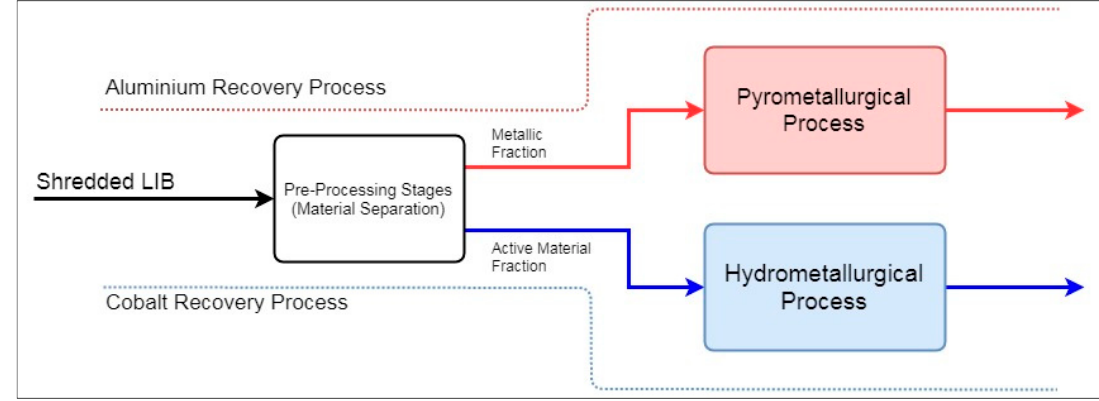
Figure 2. Flowsheet of the simulated recovery processes. LIB: Lithium-ion battery.